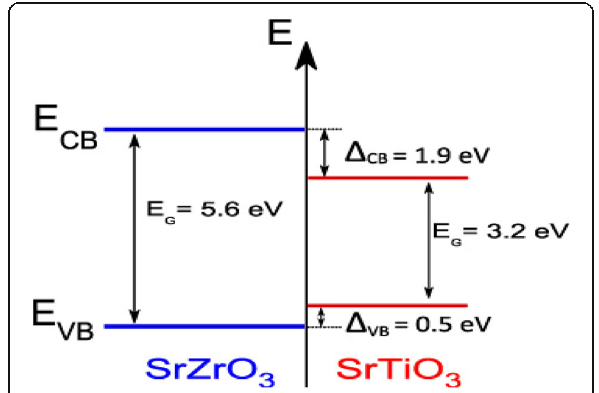
Fig. 1 The systematic representation of the type I heterojunction semiconductor